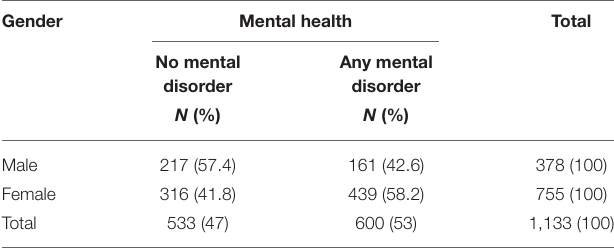
TABLE 3 | Frequency and percentage of any mental disorder by gender ( n =